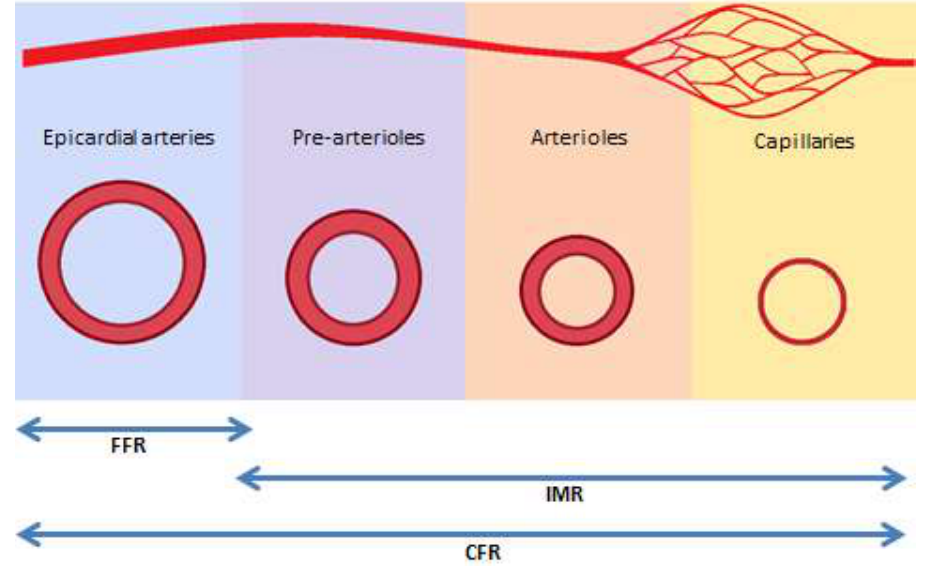
Figure 4. Functional components of invasive diagnostic tests. FFR: fractional flow reserve; IMR: index of microvascular resistance; CFR: coronary flow reserve.